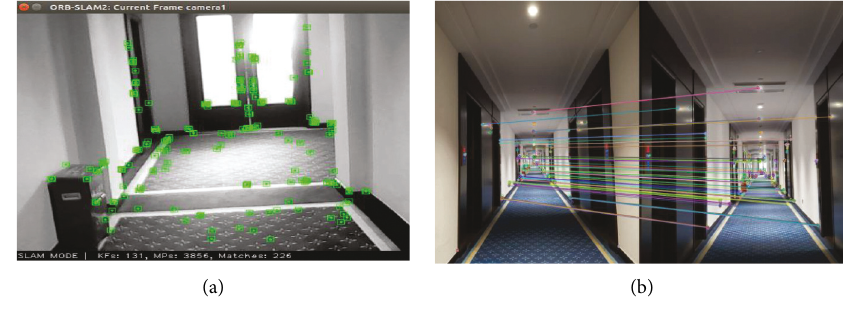
Figure 4: (a) ORB features and (b) matching